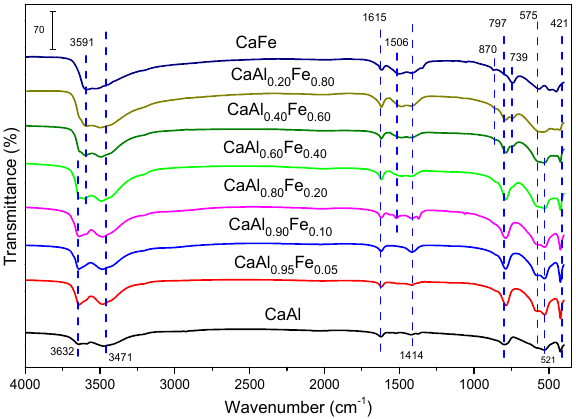
Figure 3. FT—IR spectra of the samples.